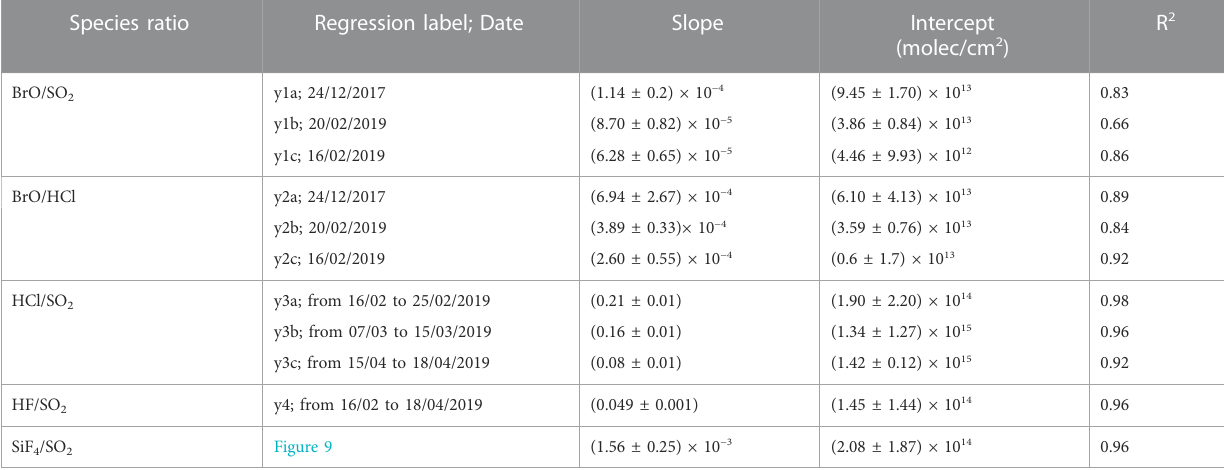
TABLE 4 Linear fi t parameters obtained from the correlation plots as presented in Figures 8 and 9. R 2 stands for the determination coef fi cient. Species ratio Regression label; Date